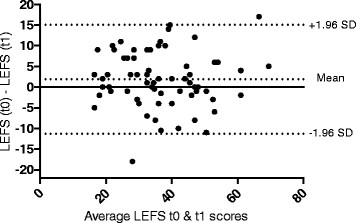
Bland & Altman plot.